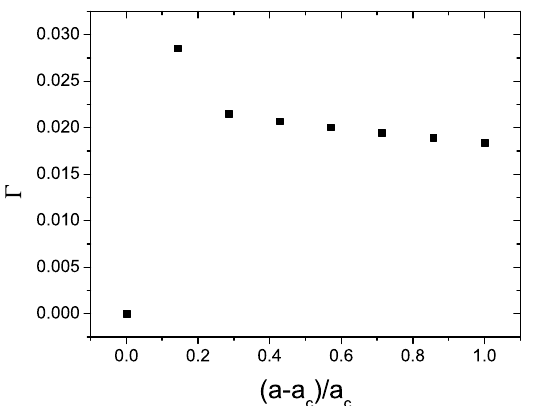
Figure 7. PS case. Adsorption Γ as a function of the difference between the reduced chemical potentials below the transition and at the transition ( θ =